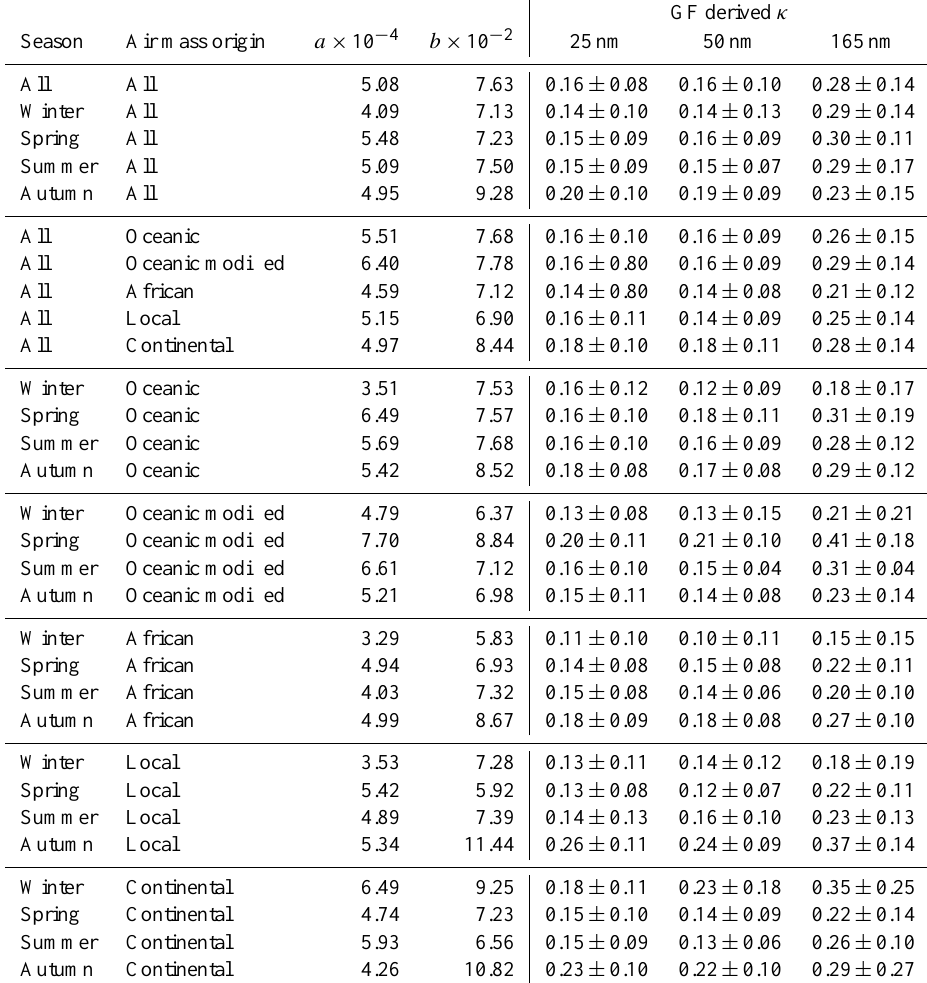
Table 6. Parameterization giving the growth factor (GF) as a function of relative humidity (RH), and the kappa value κ for each particle size, including standard